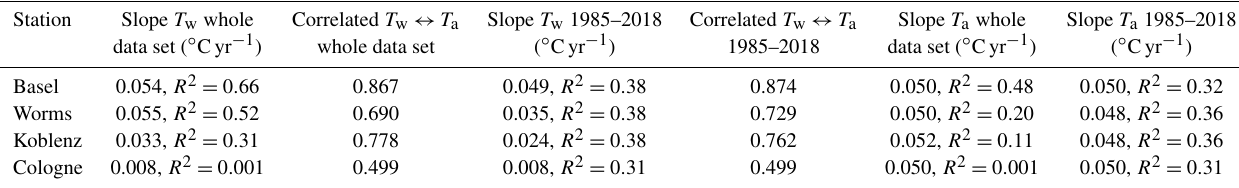
Table 4. Slope of linear fits and Pearson correlation coefficients to the daily temperature data at the four monitoring stations. The data set used is described in the column header. Next to the slope values are the R 2 values, which are statistically significant if R 2 > 0 . 19.